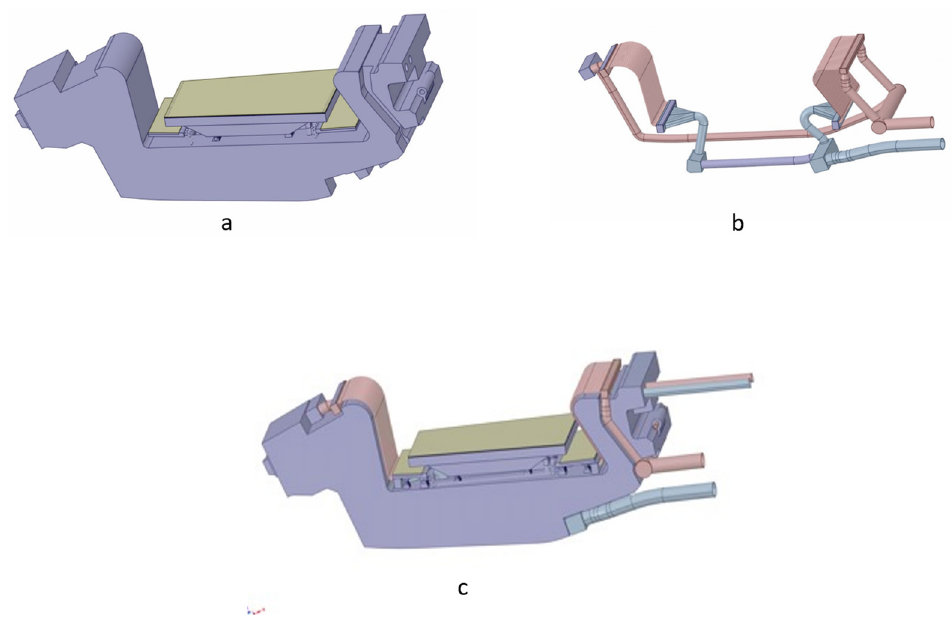
Figure 1. Divertor cassette ( a ), divertor target ( b ), assembly of cassette and target ( c ).